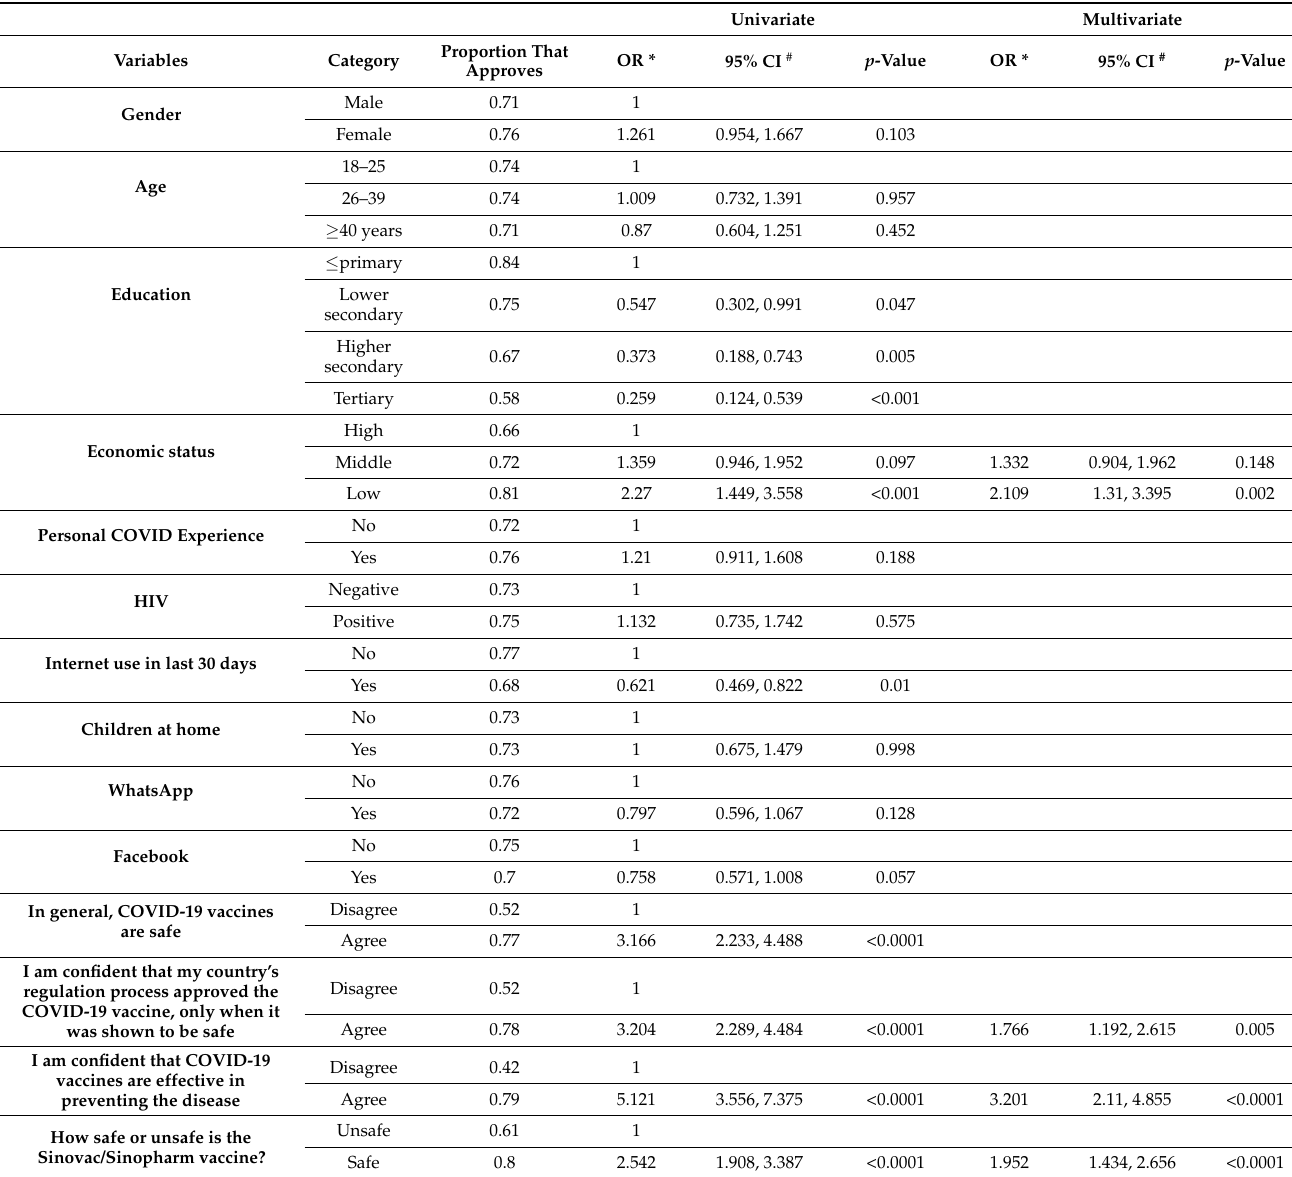
Table 4. Do you approve employers requiring a COVID-19 vaccine to get a job or certain pay allowances? (Strongly/somewhat